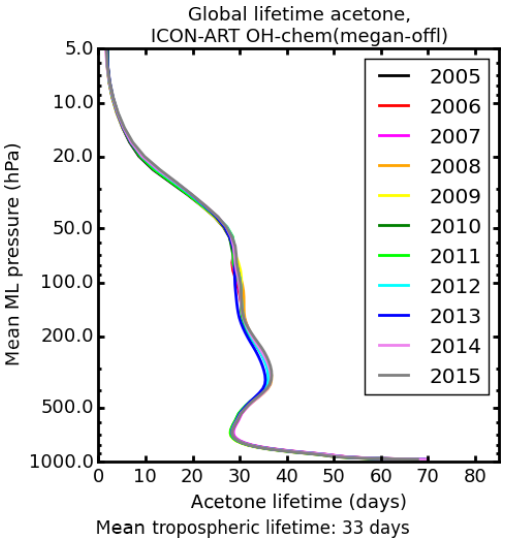
Figure 11. Global lifetime of acetone according to Eq. (13) in the OH-chem simulations averaged for each year. Definition of global lifetime by SPARC (2013) evaluated at each model